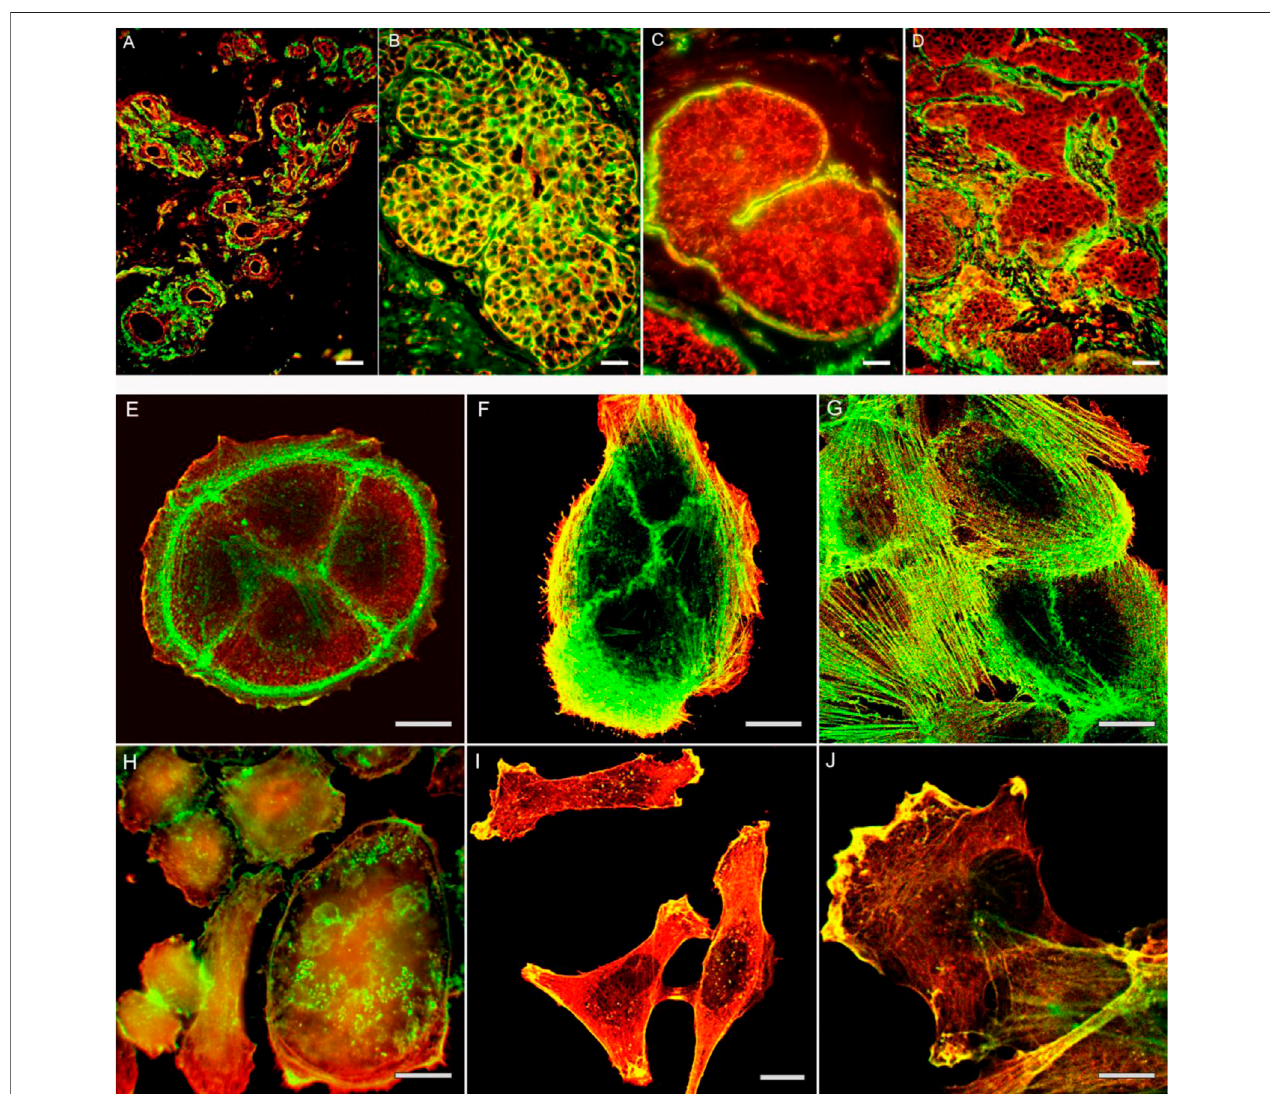
FIGURE 1 | The actin cytoskeleton organization in normal mammary gland (A) , non-malignant proliferates (B) and mammary gland cancer tissue (C,D) . Intensive staining for β -actin in cells of proliferate (B) . Decreased staining for β -actin in cells of in situ (C) and invasive (D) cancer cells on the background of positively stained myoepithelialcells (C) orstromalmyo fi broblasts (D) .Bars, 50 μ m.Theactincytoskeleton organizationinnormalepithelialcells (E,F,G) andcancercells (H,I,J) inculture. Cytoplasmic β -actin(green)and γ -actin(red)innon-malignantHaCaT (E) ,MCF-10 (F,G) epithelialcells,andcancercellculturesSiHa(H),MDA-MB-231 (I,J) .Bars, 10 μ